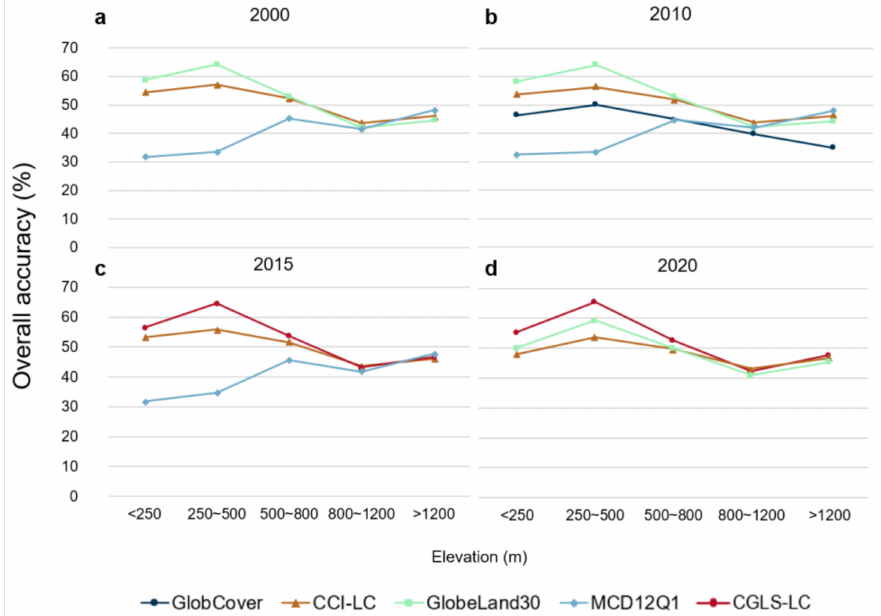
Figure 9. Overall accuracy of land cover datasets with different elevation levels for epochs ( a ) 2000, ( b ) 2010, ( c ) 2015, and ( d )